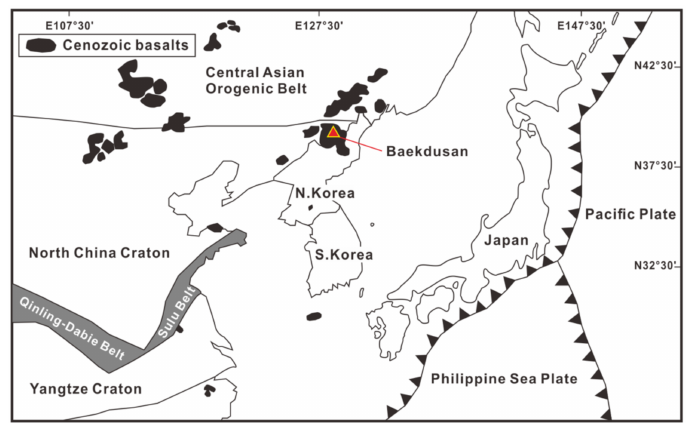
Figure 1. Simplified geologic map of the Baekdusan area showing the distribution of Cenozoic intraplate basalts in northeastern China and Korea (modified from [21,23,24]) and the sampled location at